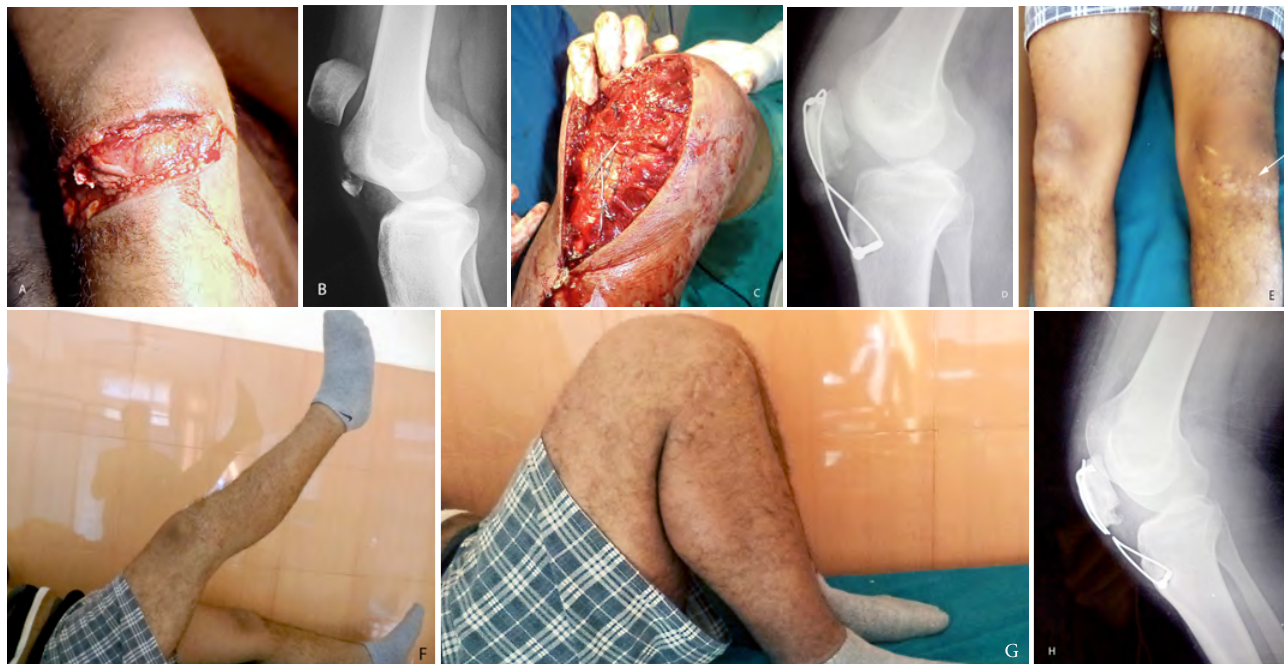
Fig 3 : ( A ) Compound patella fracture in 10 yrs old male following MVA; ( B ) Preoperative radiograph show displaced inferior pole patella fracture; ( C ) Intraoperative picture to ensure that there was no tilting of the patella in the sagittal plane following resection and transosseous repair of patella ligament with patellotibial fixation; ( D ) Postoperative lateral radiographs; ( E,F,G ) Ten months followup show excellent result without any loss of function; ( H ) A lateral radiograph taken 10 months postoperatively shows good healing (note broken wire).